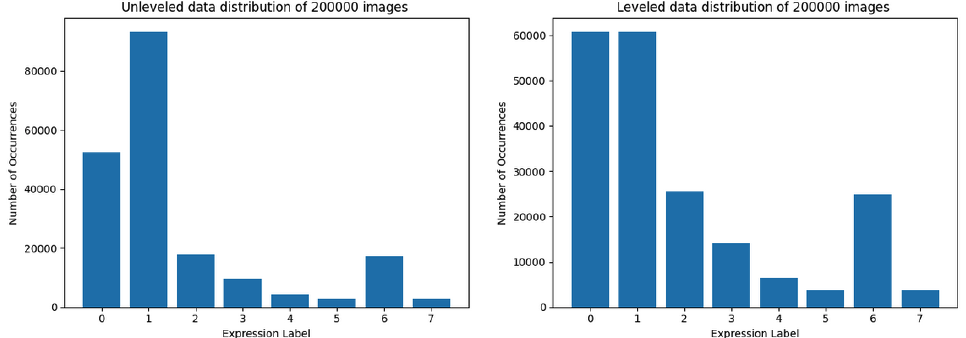
Figure 6. Data distribution of training set composed of 200,000 images. At the left side is data distribution using the first method, at the right using the second